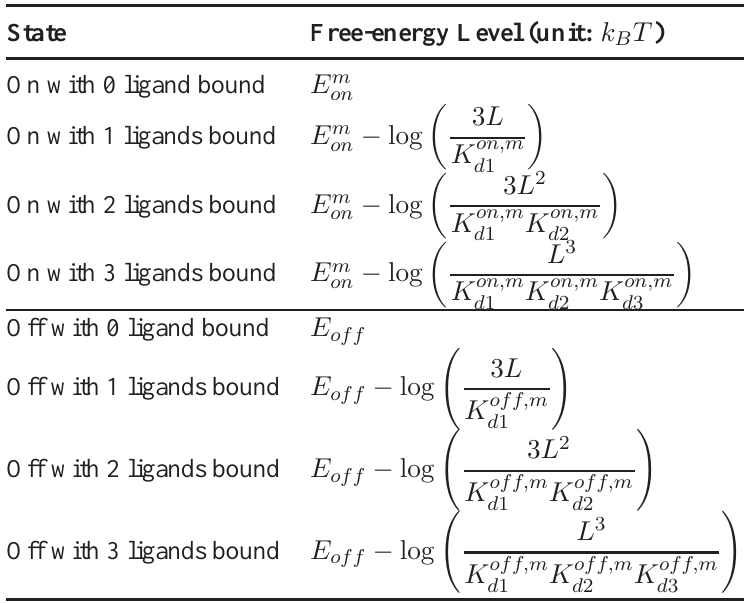
Table 3. Free-energy levels for a pure-type trimer of